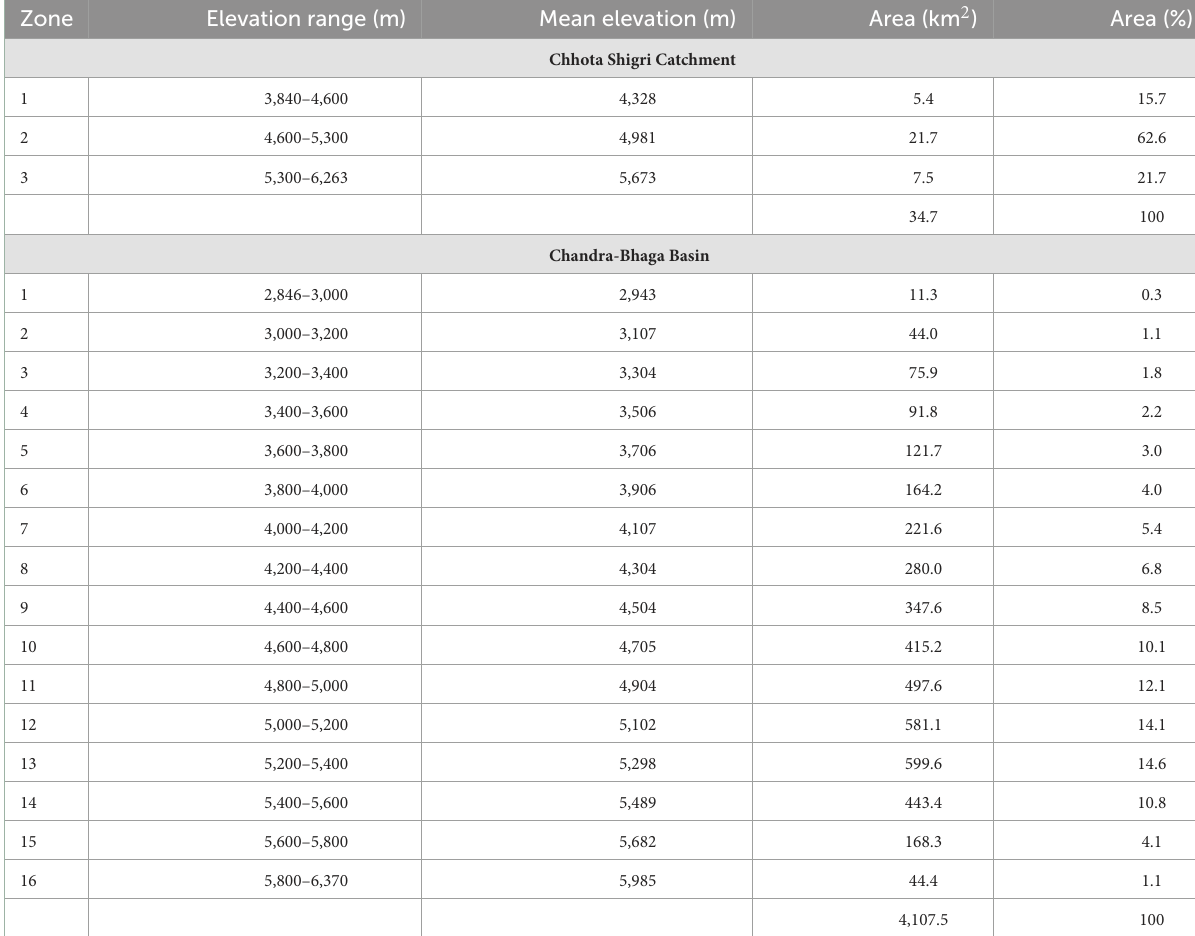
TABLE 1 Characteristics of different zones used in SRM for Chhota Shigri Catchment and Chandra-Bhaga Basin. Zone Elevation range (m) Mean elevation (m) Area (km 2 ) Area